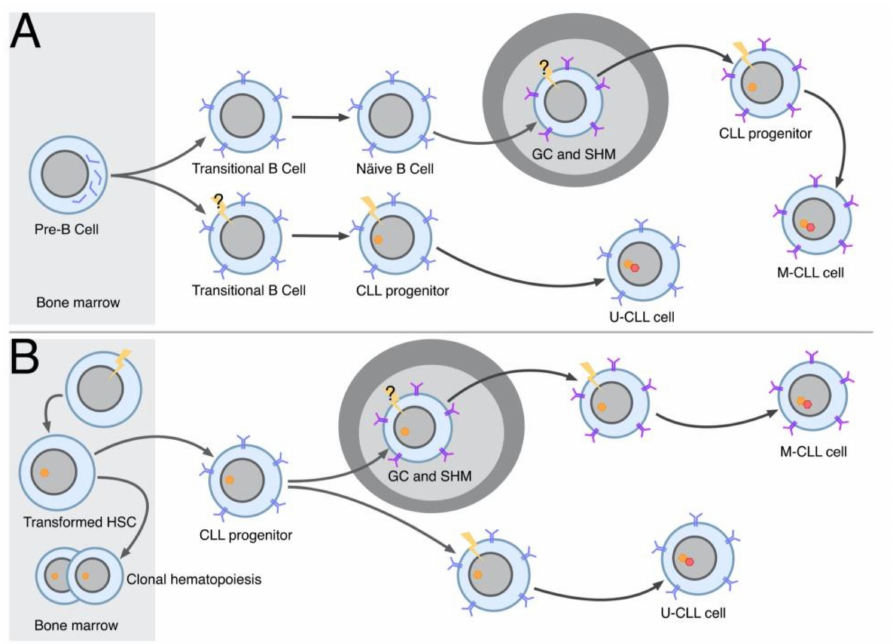
Figure 4. Models of CLL leukemogenesis. ( A ) Origin of CLL from B cells expressing a fully assembled BcR. The pathways of the origins of M-CLL (top) and U-CLL (bottom) cells are portrayed separately. The multistep transformation of M-CLL may be initiated already in the germinal center (GC), where so- matic hypermutation (SHM) occurs (this step is indicated with a question mark). The transformation of U-CLL cells may be initiated already in transitional B cells (again indicated with a question mark), although it can certainly take place in naïve cells, which become progenitor CLL cells. Most of the transformation/selection process is promoted by BcR engagement. ( B ) Origin of CLL from hematopoietic stem cells. An HSC becomes a transformed HSC in the bone marrow and starts to generate oligoclonal CLL cell progenitors with features of mature B lymphocytes, which are subsequently exposed to additional transforming events. Among these transformed cells, one is eventually selected and this leads to full-blown CLL. This process of further transformation/selection promoted by BcR engagement occurs outside the GC for U-CLL cells, whereas it includes a passage in the GC for M-CLL cells. As discussed in the text, transformed HSCs are responsible for clonal hematopoiesis, predominantly giving rise to B cells but also including other